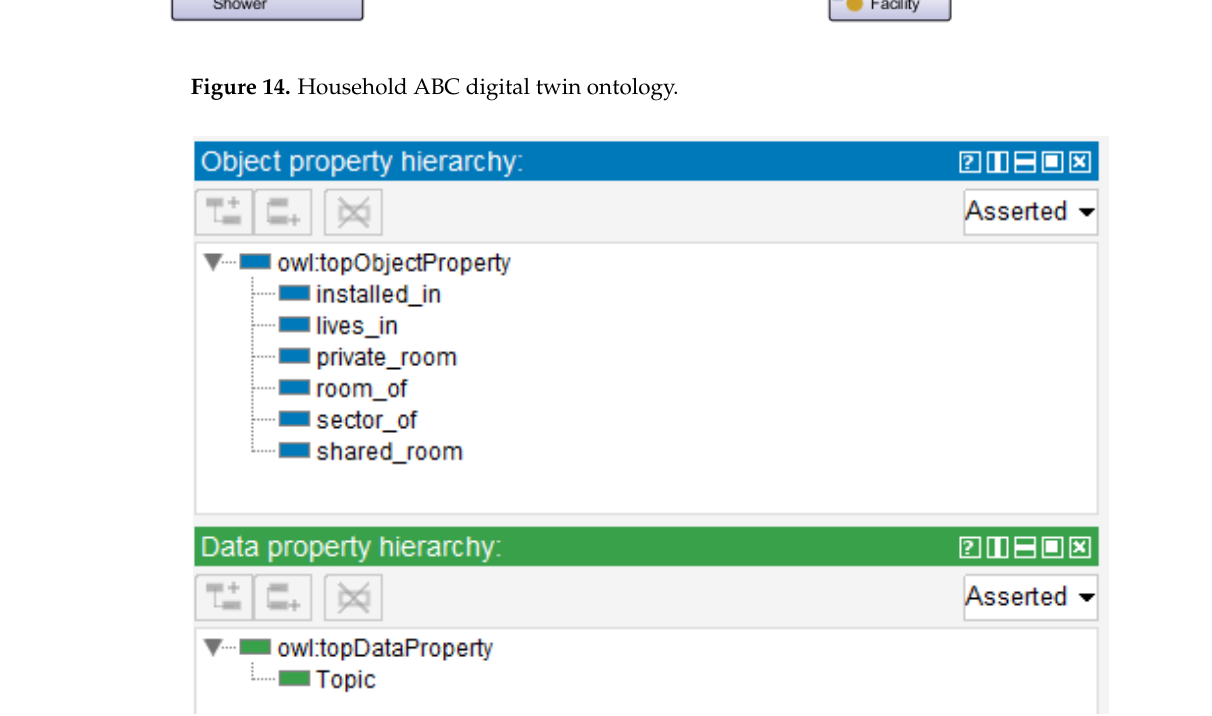
Figure 15. Digital twin smart home ontology relations and data